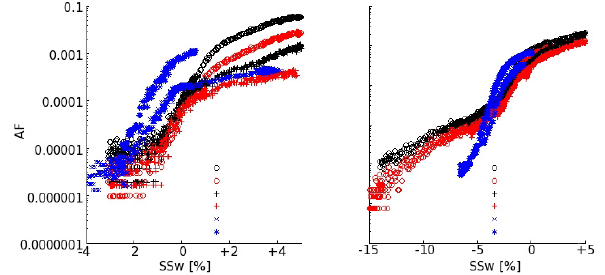
Fig. 10. Arizona test dust SS-scans. MINC results are shown in blue, CSU-CFDC results are shown in black (2µm threshold) and red (3µm threshold). Results are shown for (a) Sample tempera- ture − 25 ◦ C, and (b) sample temperature − 31 ◦ C. Legend: “M” – MINC instrument results. “C” – CSU-CFDC instrument